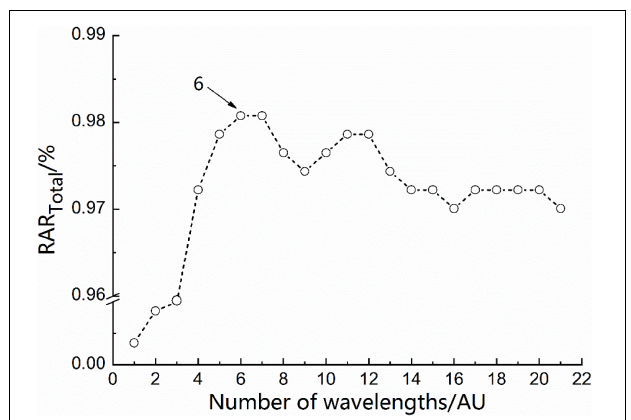
FIGURE 5 | Total recognition accuracy rate (RAR Total ) in the process of wavelength step-by-step phase-out (WSP) for the equidistant combination (EC)-Bayes